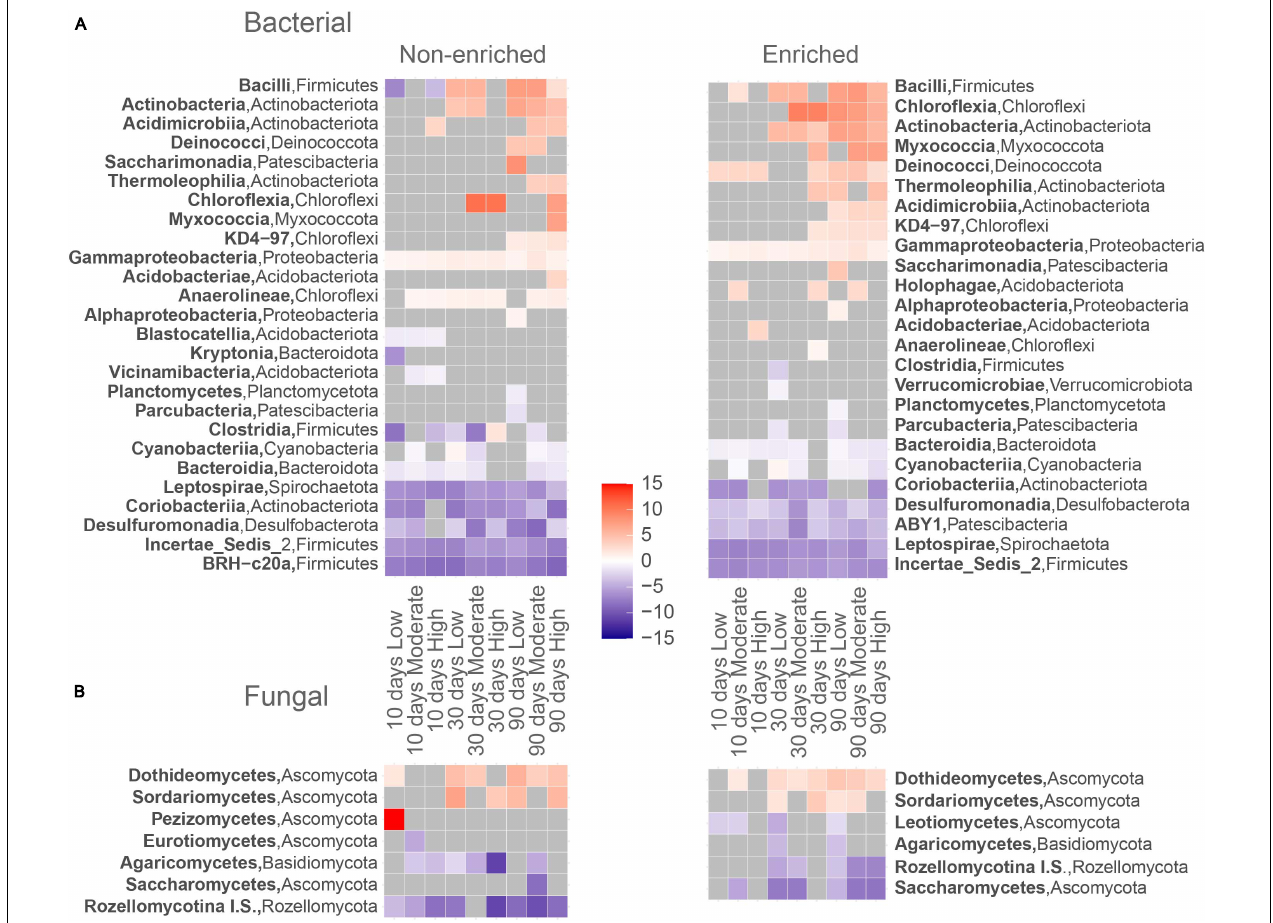
FIGURE 4 | Log2-fold change heatmap for abundant ( > 1%) significantly responsive (A) bacterial and (B) fungal ASV’s for each treatment to its corresponding prior to drying assembly. Assigned red squares represent ASV’s that significantly increase (tolerant to drying) and blue squares ASV’s that significantly decrease (sensitive to